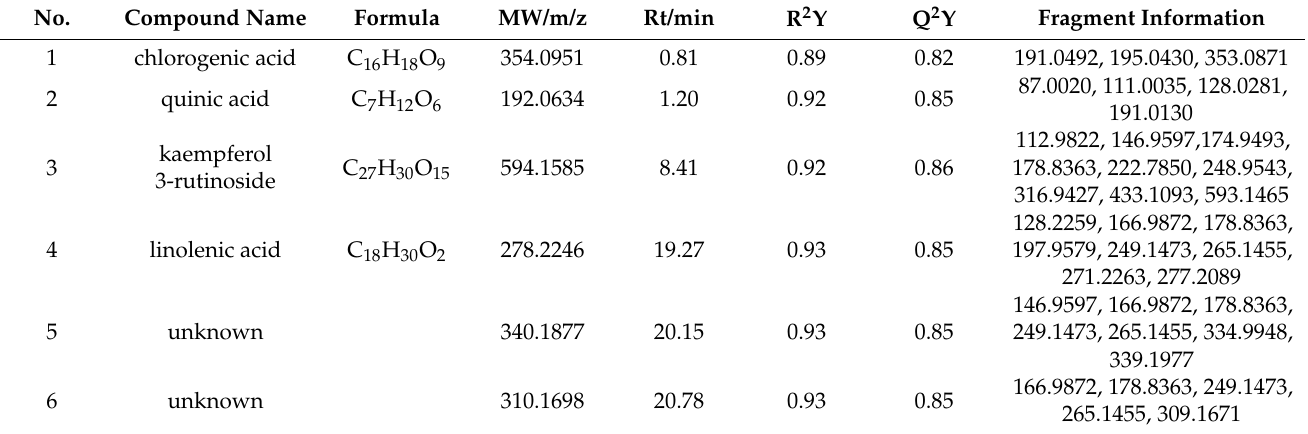
Figure 3. The spectral-effect relationships between the chemical composition and anti-cancer activity of T. hemsleyanum on HuH-7 cells. PCA scores of metabolites of T. hemsleyanum extracts with respect to the anti-cancer IC 50 of HuH-7 ( A ); PLS modeling of metabolites of T. hemsleyanum extracts with respect to the anti-cancer IC 50 of HuH-7 ( B ). Table 4. Identification of chemical components of T. hemsleyanum metabolites associated with HuH-7 hepatocellular carcinoma